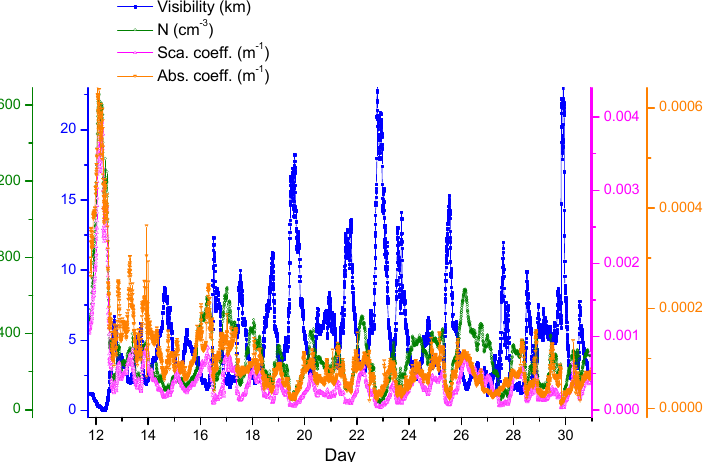
0.51, respectively. A relatively poor negative correlation is found between the absorption coefficient and atmospheric visibility.